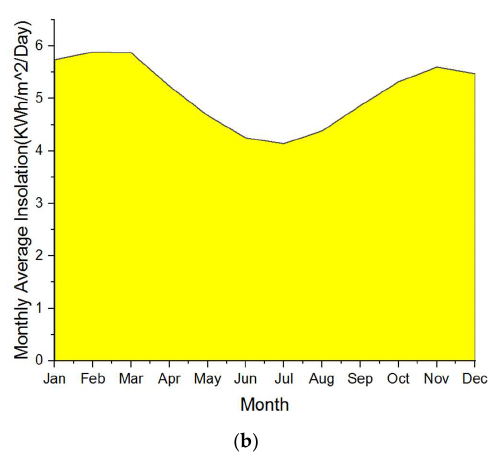
Figure 8. ( a ) Temperature profile of the location; ( b ) Irradiance profile of the location. Table 2 . Parameters for microgrid simulation.